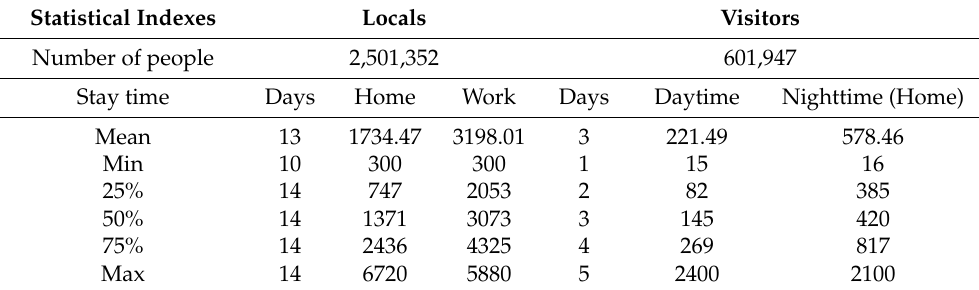
Table 3. Statistical description for maximum stay times (minutes) during the day and at night for locals and